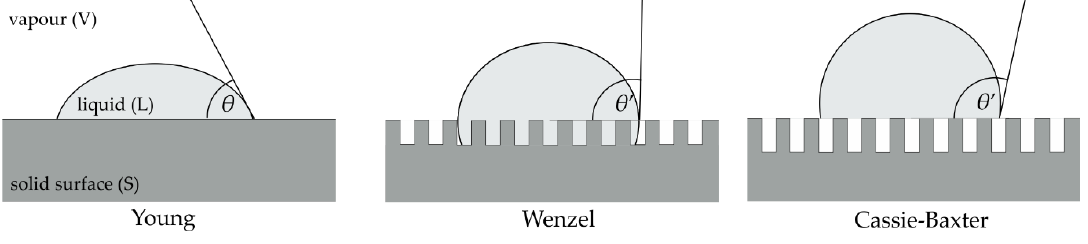
Figure 2. Behavior of liquid on smooth and rough surface